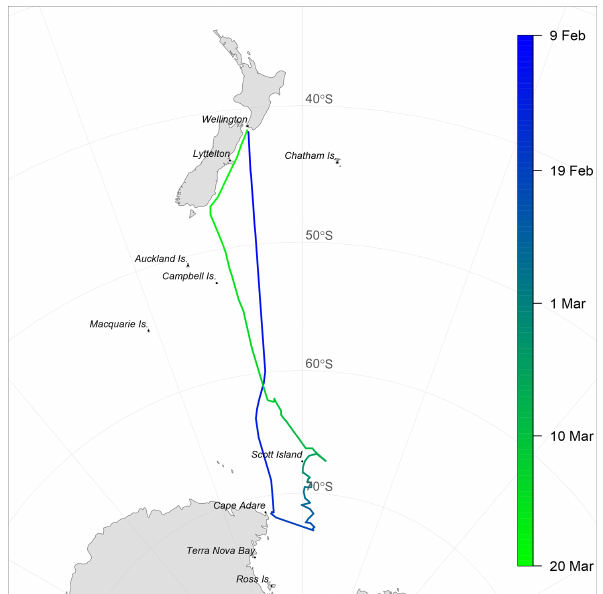
Figure 1. The ship track of the RV Tangaroa with dates indicated by colours. The 2018 Southern Ocean Ross Sea Marine Ecosystem and Environment voyage extended from the North Island of New Zealand to off the coast of Cape Adare